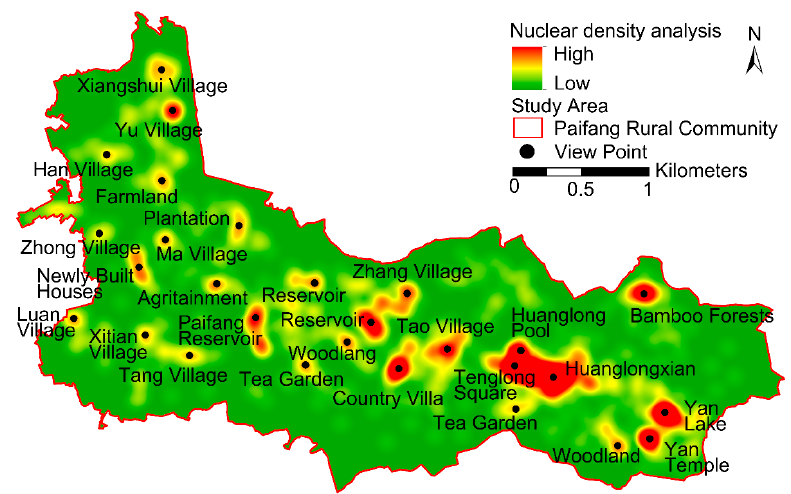
Figure 5. Spatial distribution density of social value points in the Paifang rural community.